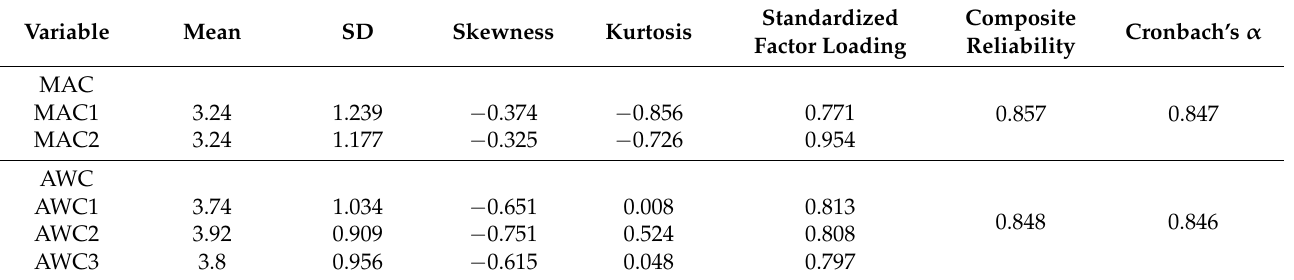
Table 3. Measurement model assessment ( n =